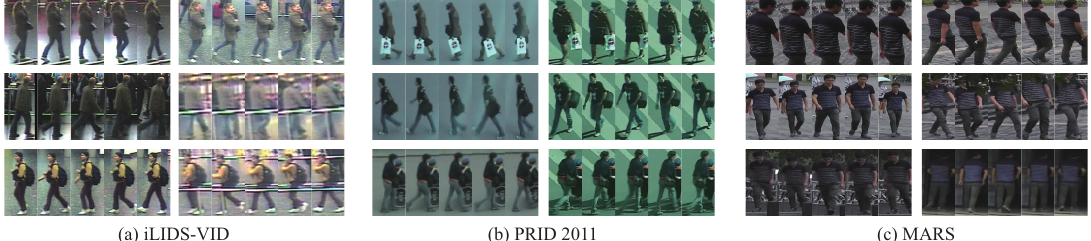
Figure 8. Example pairs of the image sequences of the same person in different camera views from two datasets. ( a , b ) shows images of one person with two different cameras in each row, in iLIDS-VID and the PRID 2011 dataset, ( c ) shows images of one person with six different cameras in MARS.